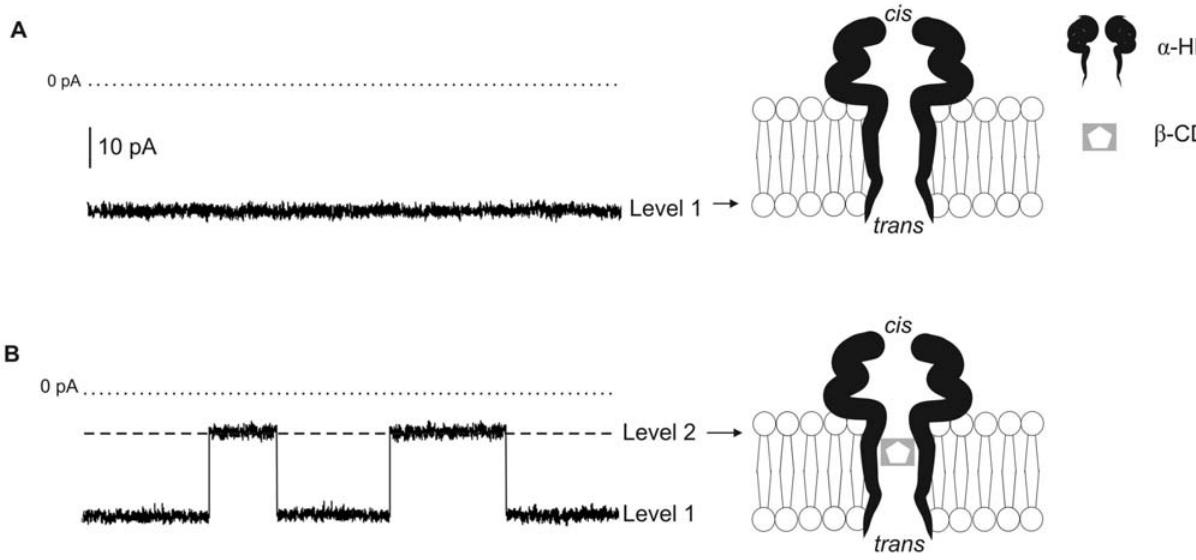
Figure 6. Black lipid membranes recordings of single α -hemolysin ( α -HL) pore with β -cyclodextrin ( β CD). Currents were recorded at –40 mV ( cis at ground). α -HL pore was entering from the cis side and β CD from the trans side. (A) Single a-HL pore constantly open at around –30 pA (level 1); (B) β CD partially blocking the channel at around 10 pA (level 2). Adapted from Gu et al. 91 with